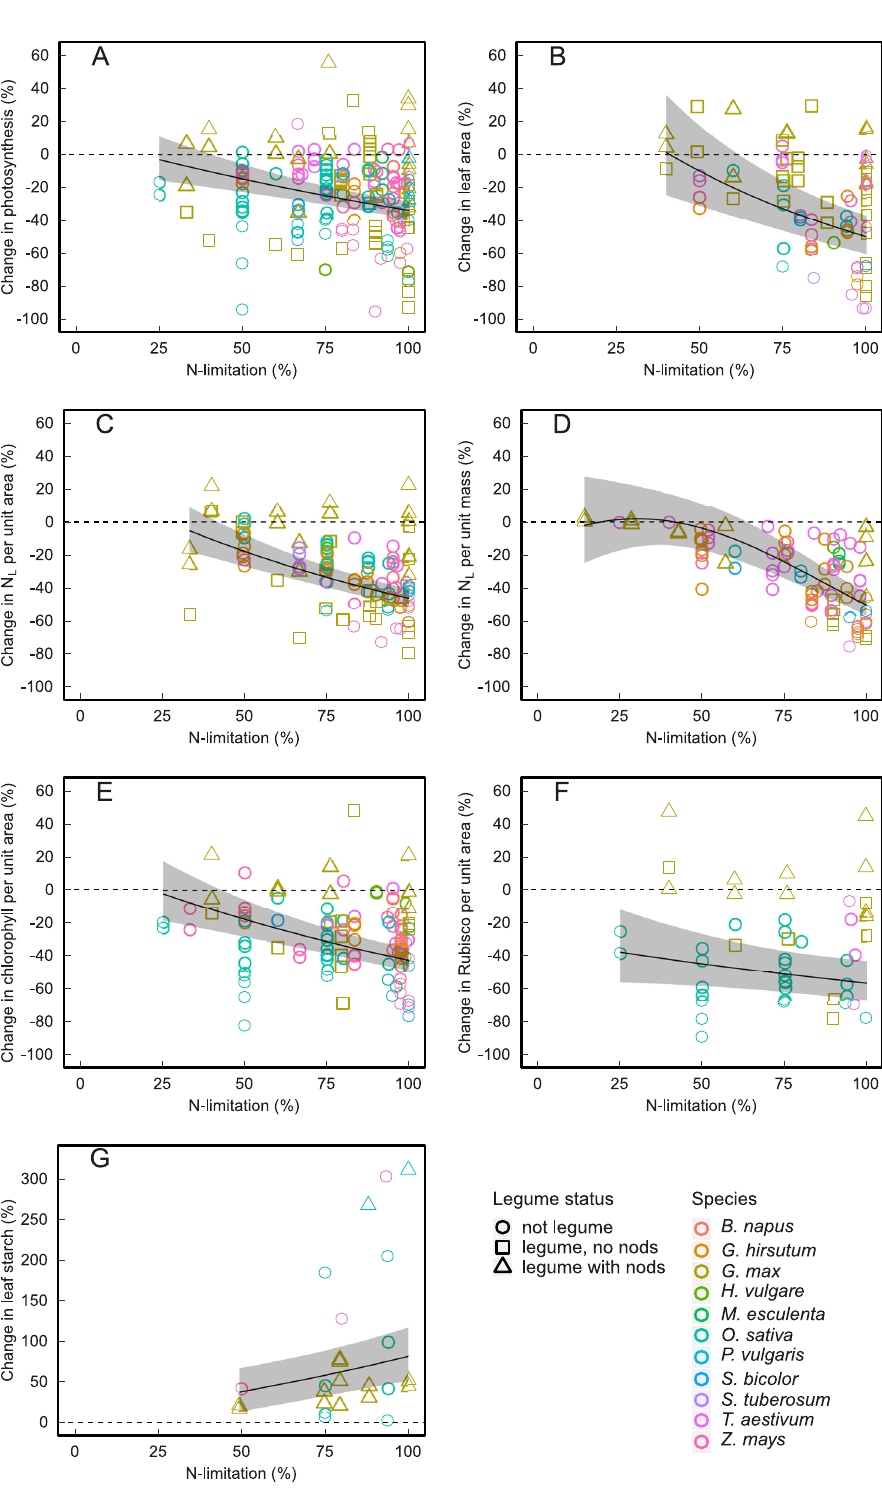
PLOS ONE | https://doi.org/10.1371/journal.pone.0223508 October 17,